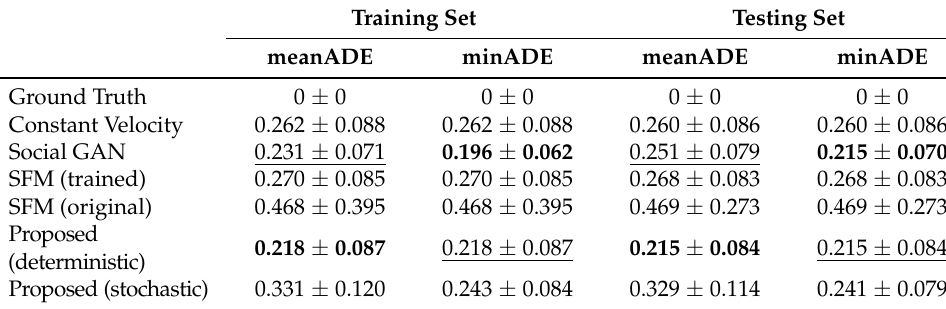
Table 4. Evaluation of ADE